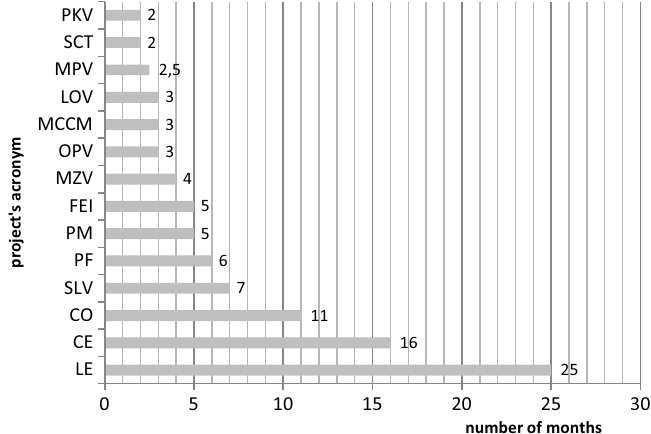
Fig. 4. Time devoted to scenario method employment in Polish regional and sector foresight projects Source: own work based on questionnaire